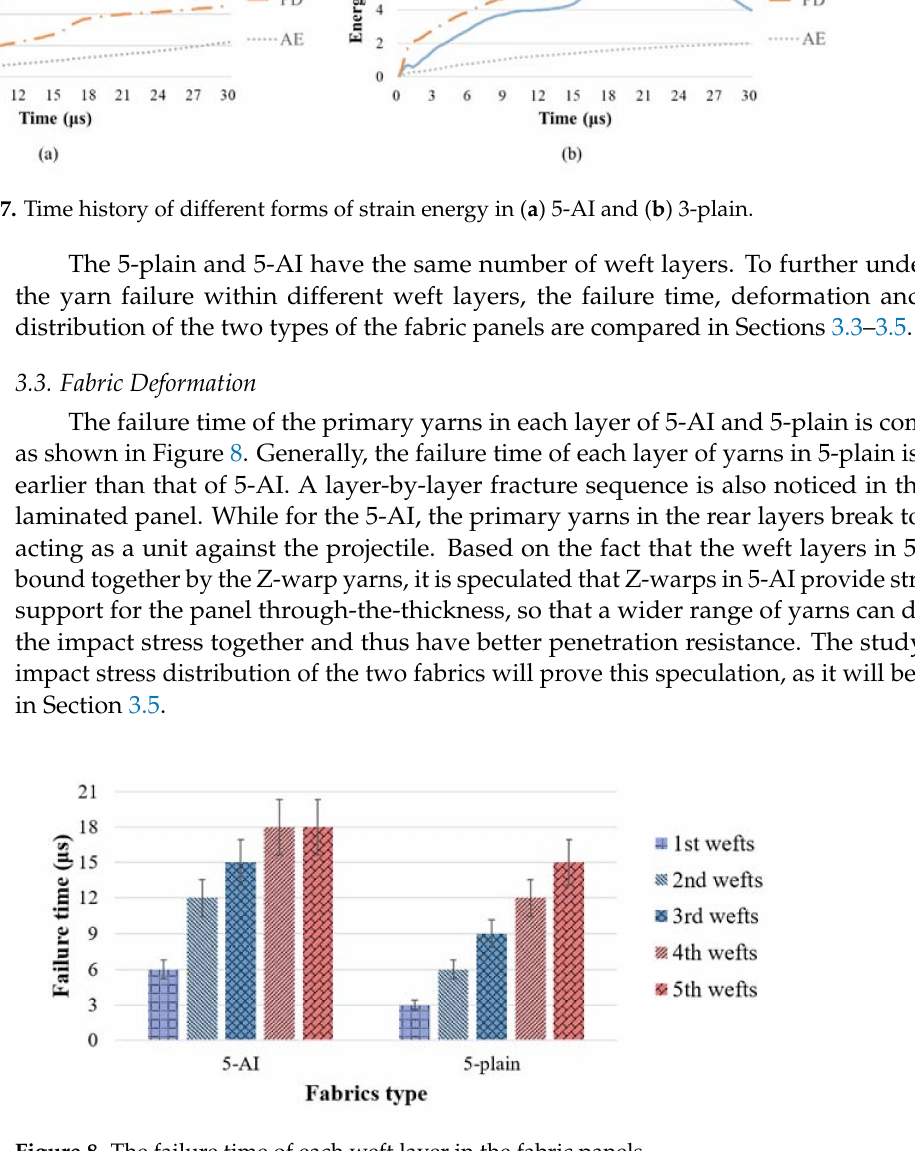
Figure 8. The failure time of each weft layer in the fabric